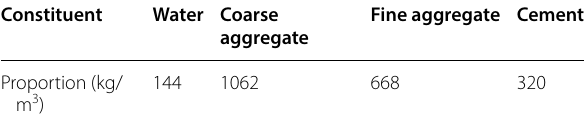
Table 1 Mix design proportions of constituents.